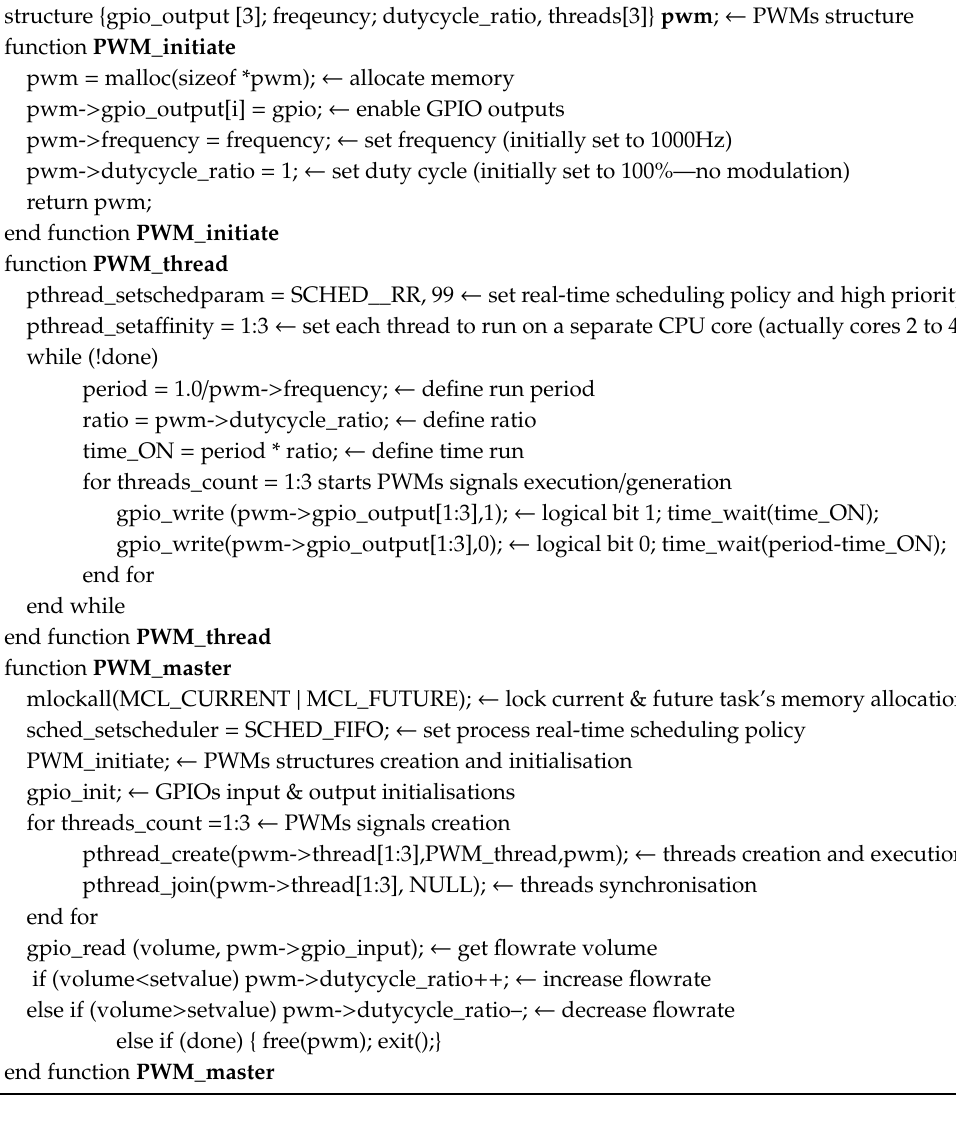
Algorithm 1 : Master module control structures